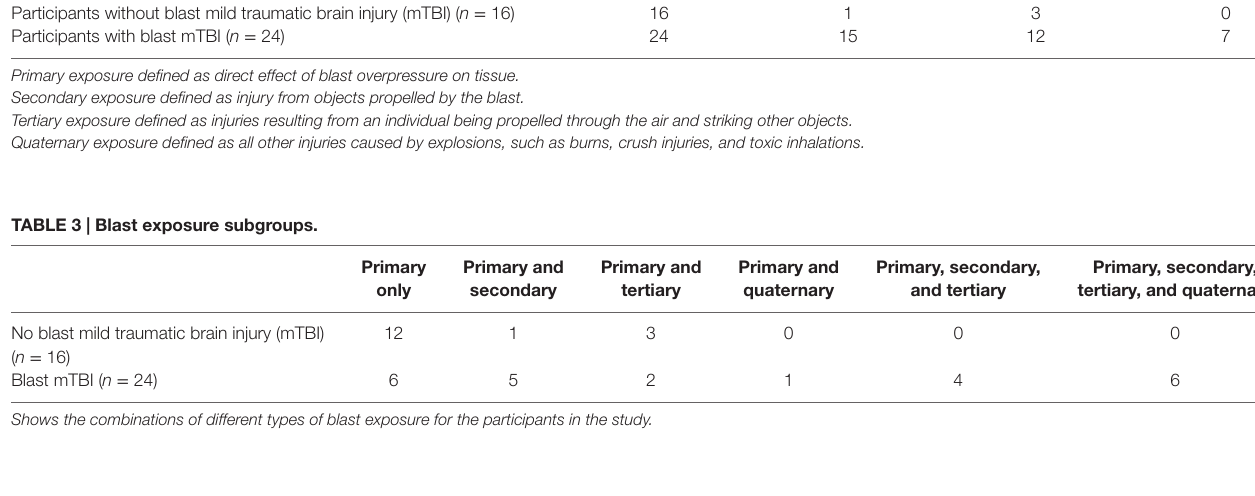
Primary and quaternary